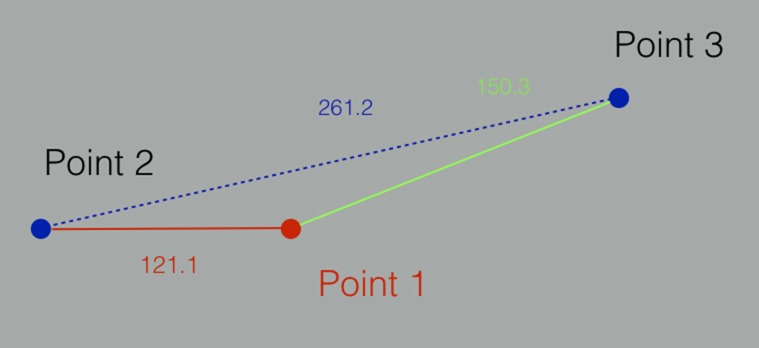
Schematic model produced by the plugin of the points selected and the distance between them.